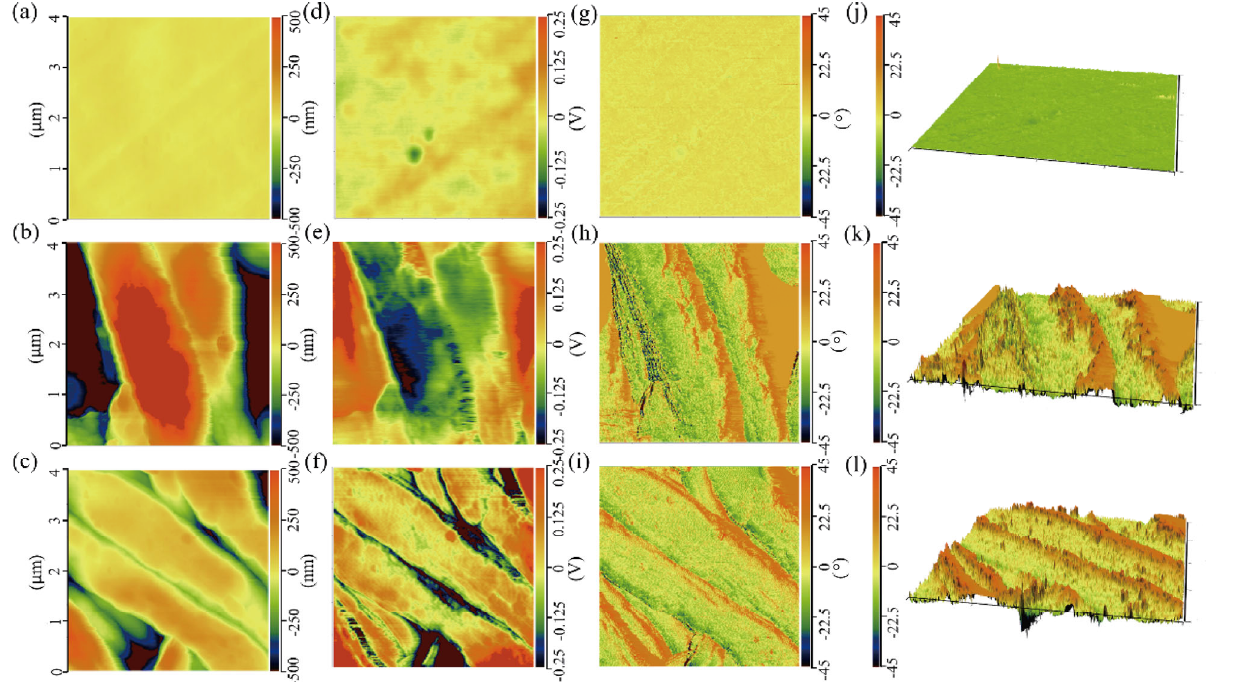
Fig. 5 Topographic images of (a) cast film, (b) internal fibers, (c) surface fibers; KPFM images of (d) cast film, (e) internal fibers, (f) surface fibers; phase images of (g, j) cast film, (h, k) internal fibers, and (i, l) surface fibers in 10 wt% PZT/PVDF